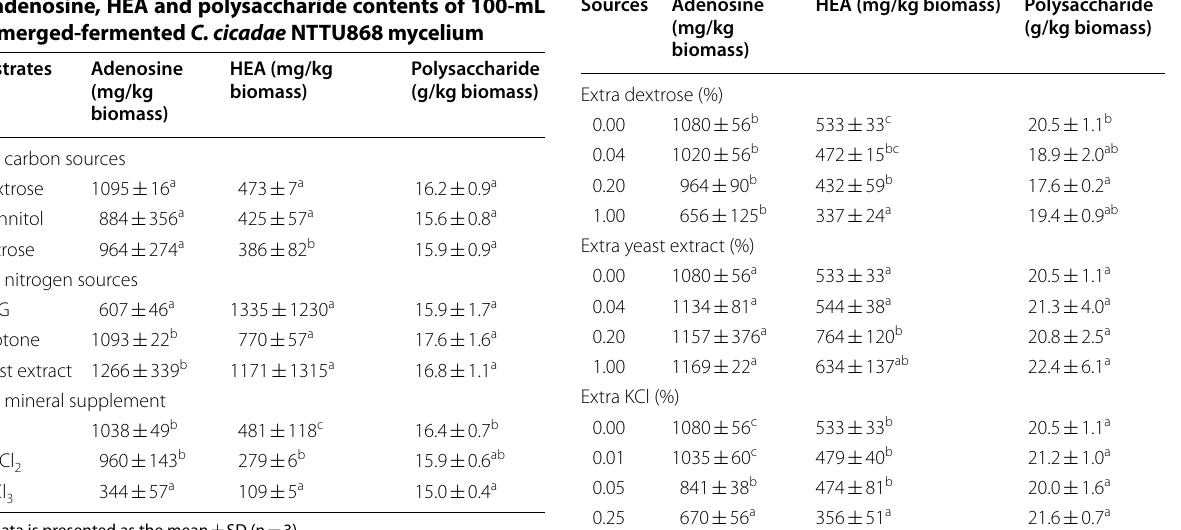
The data is presented as the mean MSG monosodium glutamate, KCl potassium chloride, MgCl 2 magnesium chloride, FeCl 3 ferric chloride a,b Different letters indicate significantly different values according to a one-way ANOVA with Duncan’s multiple test ( p < 0.05)